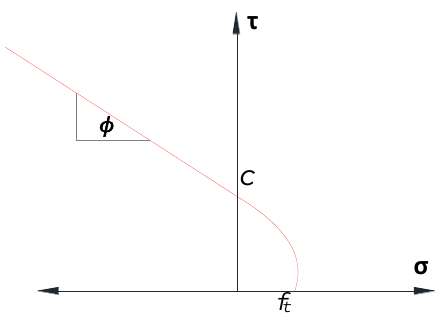
Figure 7. Mohr – Columb failure surface for the interface material. Figure 7. Mohr–Columb failure surface for the interface